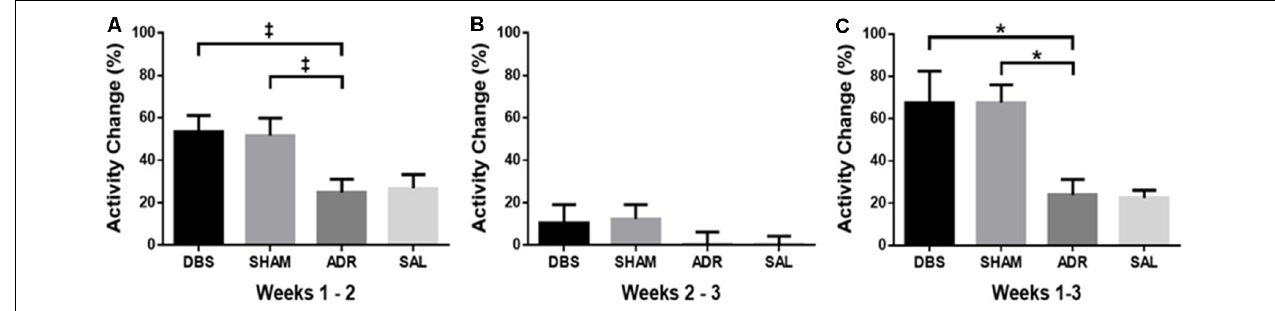
FIGURE 5 | Percent change in homecage activity counts between (A) pretreatment baseline and the first week of ACTH treatment (days 1–7), (B) first week of ACTH treatment (days 1–7), and second week of ACTH treatment with DBS (days 8–15), (C) pretreatment baseline and second week of ACTH treatment with DBS